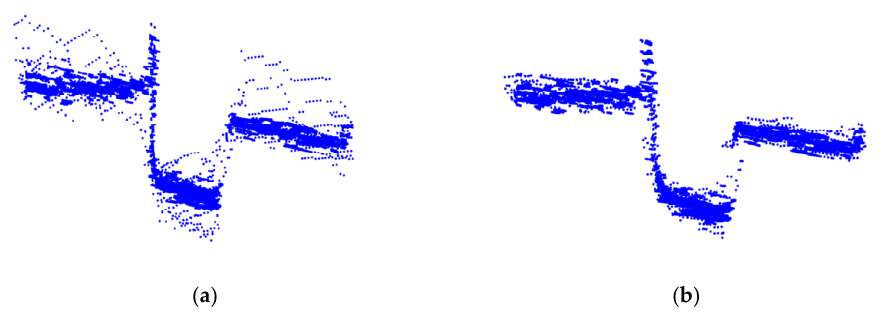
Figure 5. Point cloud ( a ) before clustering and ( b ) after clustering.